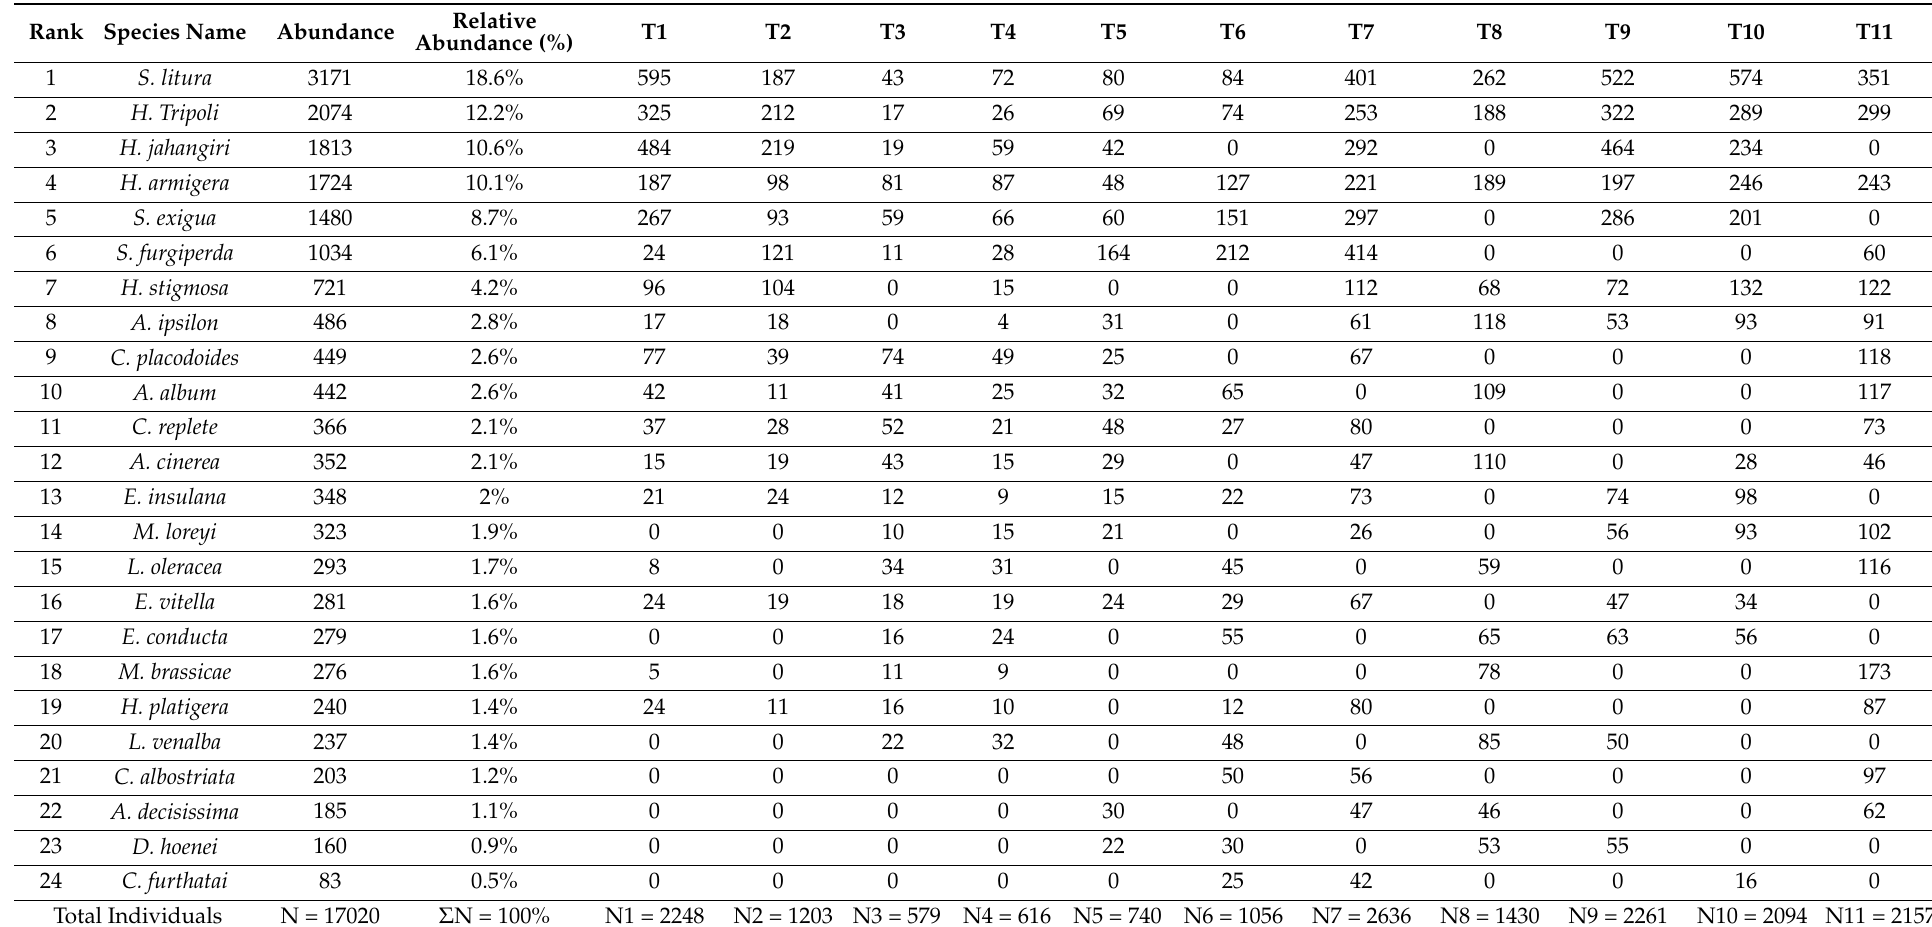
Table 2. The collective rank list and abundance of all species from all traps in the region of Multan,